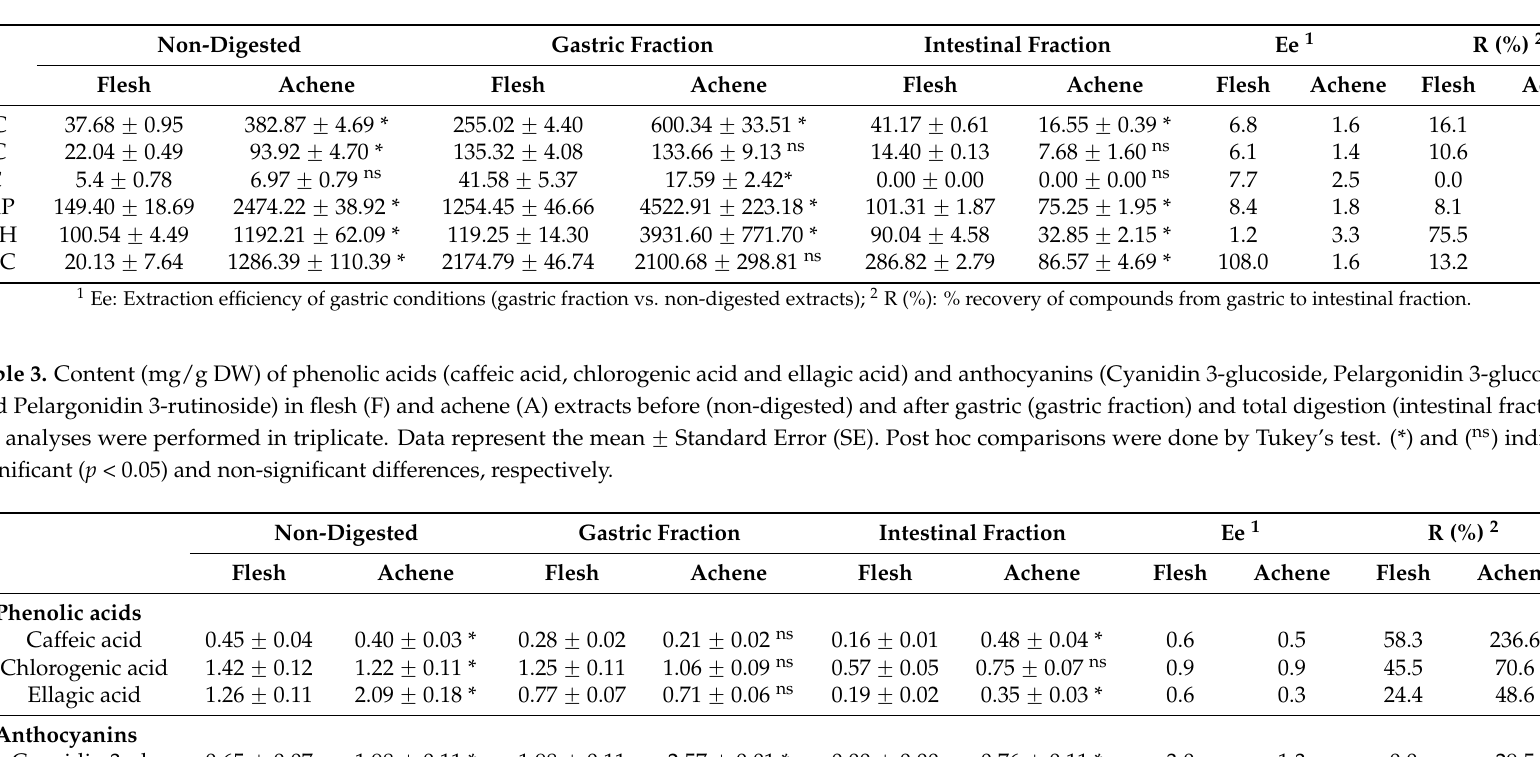
Table 2. Content of total phenolics (TPCs; mg GAE/g DW), total flavonoids (TFCs; mg CE/g DW), and total anthocyanins (ACs; mg Pel-glc/g DW), and antioxidant capacity (in mg TE/g DW), determined by FRAP, DPPH and TEAC in flesh (F) and achenes (A) extracts before (non-digested) and after gastric (gastric Fraction) and total digestion (intestinal fraction). All analyses were performed in triplicate. Data represent the mean ˘ Standard error (SE). Post hoc comparisons were done by Tukey’s test. (*) and ( ns ) indicate significant ( p < 0.05) and non-significant differences, respectively.